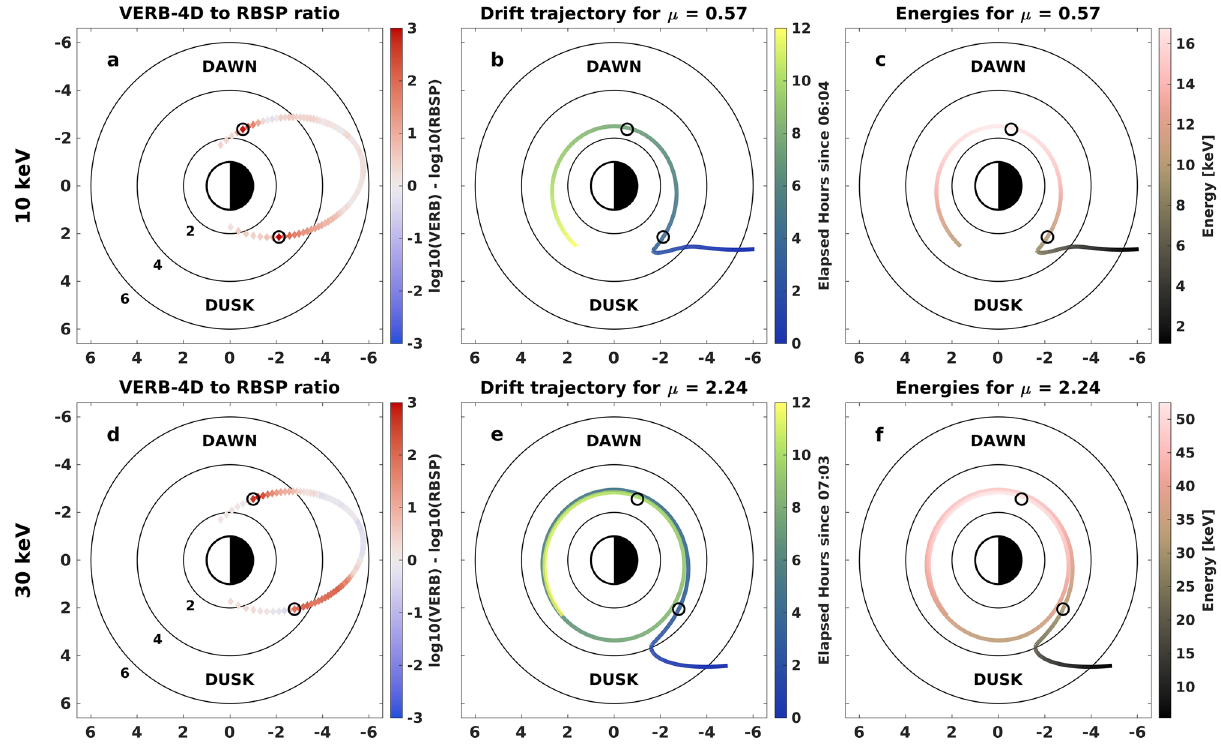
Figure 3. Spatial location of overestimation and the electrons’ drift paths. (a) Comparison between flux measured by RBSP-B and VERB-4D for the orbit starting around 09:00 and 10keV . The black circle indicates the innermost point, where overestimation was greater than one order of magnitude on the given trajectory. (b) Calculated drift trajectory for a 10keV and 50 ◦ pitch-angle electron crossing the point of innermost overestimation on the dusk-side indicated again by the black circle. Color-coded is the elapsed time of the drift starting at the injection of the particle at GEO. (c) Same drift paths as in wave-particle interactions but now color-coded is the energy of particles along the drift path. (d–f) Same format as (a–c) but for 30keV